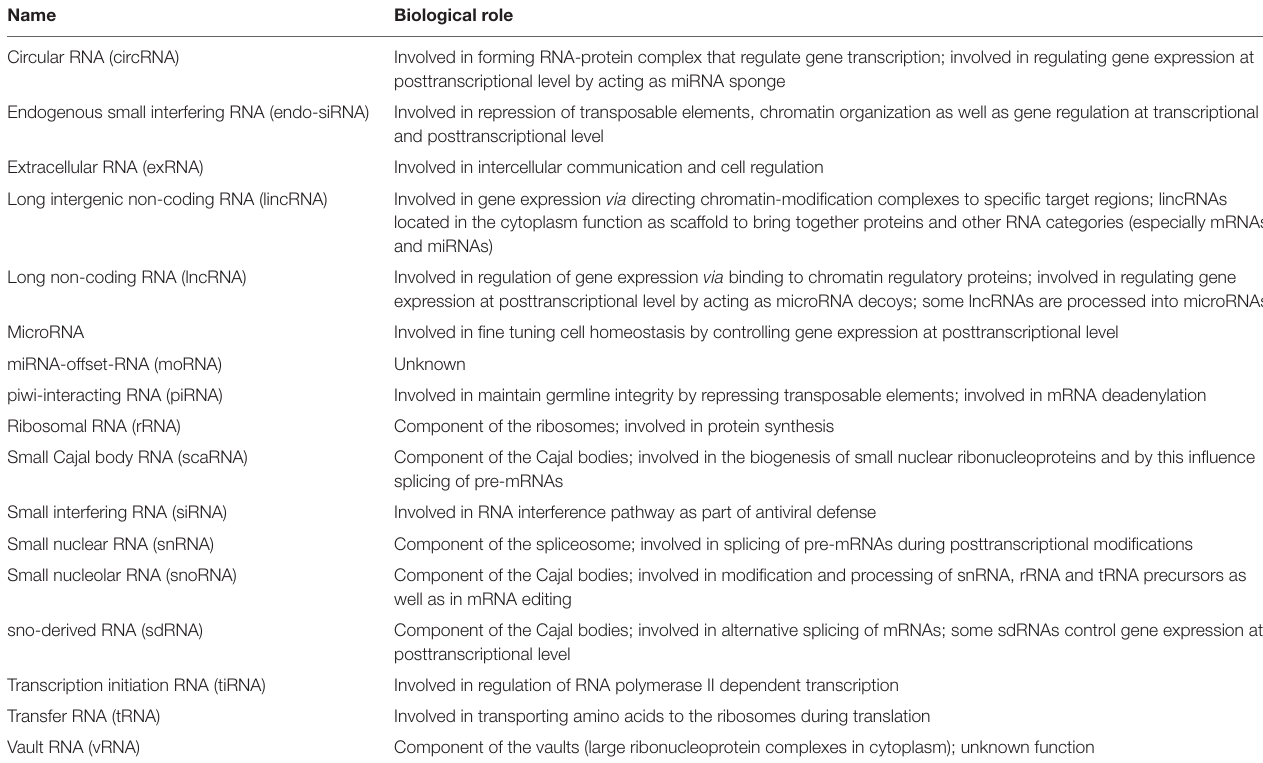
TAble 2 | Overview about the different categories of non-coding RNA molecules.